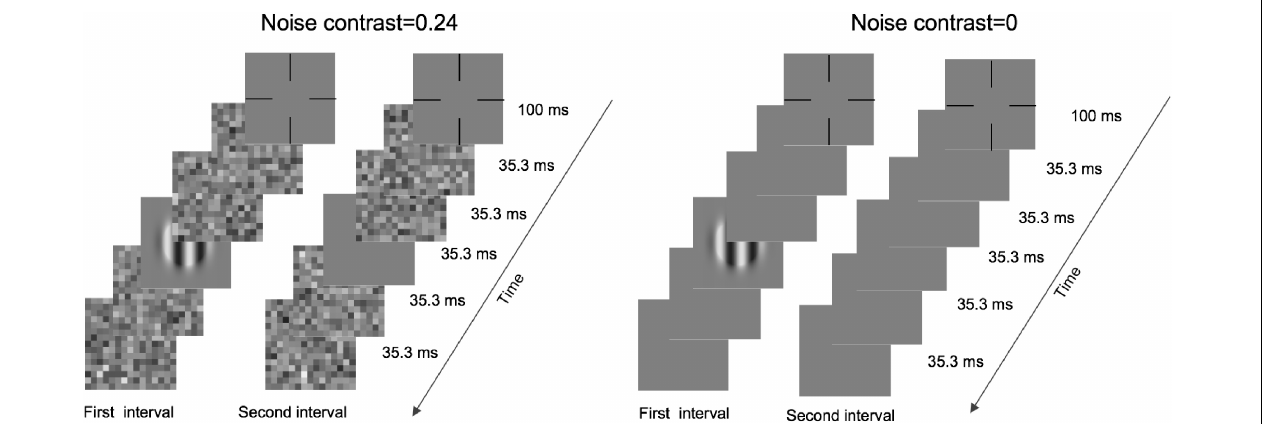
FIGURE 1 | Illustration of a typical trial under high- (left) and zero- (right) noise